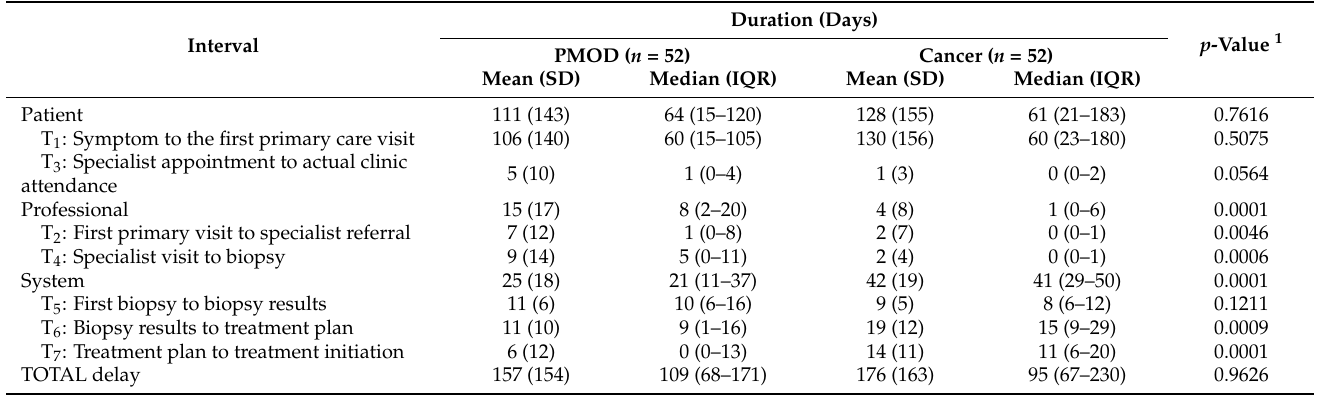
Table 3. Breakdown of time-to-treatment (days) by